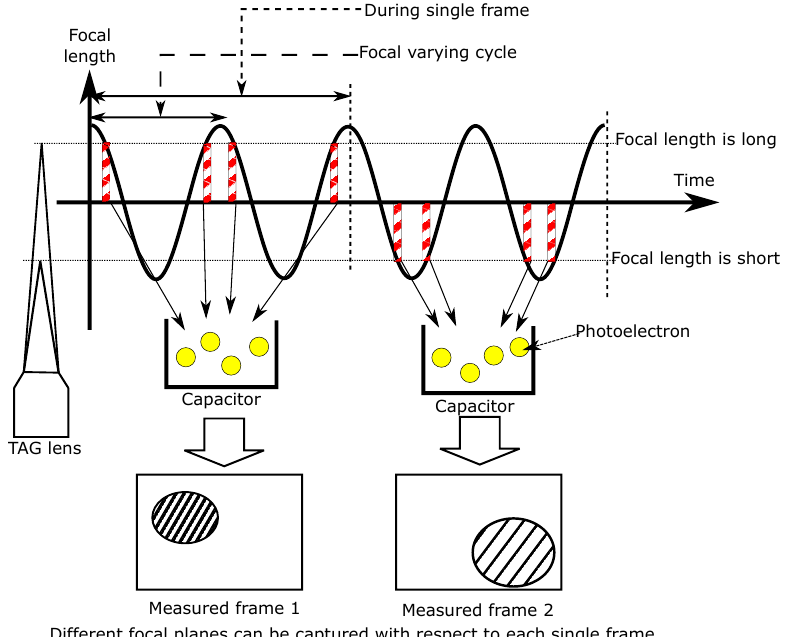
Figure 1. Schematic diagram of synchronous driving of the temporally coded exposure (TeCE) camera and tunable acoustic gradient index (TAG) lens. In measuring frame 1, four short exposures are carried out when the focal length of the TAG lens is long, and the photoelectrons generated by the four exposures are accumulated. Frame 2 is obtained in the same way as frame 1, but the focal length for the exposures is different. If the focal length is different, the focal plane is also different. Therefore, frame 1 and frame 2 capture different focal